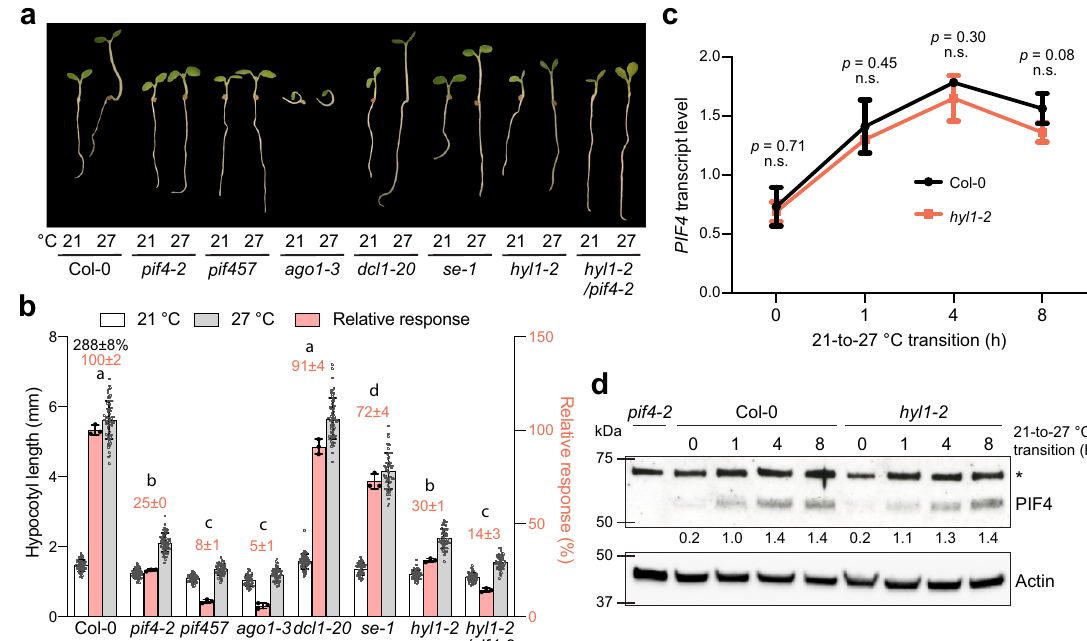
c qRT-PCR analysis of the PIF4 transcript levels in 4-d-old Col-0 and hyl1-2 seed- lingsgrownunder50 μ molm − 2 s − 1 Rlightattheindicatedtimepointsduringthe21- to-27°C transition. Thetranscript levelswere quanti fi ed relative to those of PP2A . Errorbarsrepresentthes.d.ofthreebiologicalreplicates.Thecentersoftheerror bars represent the mean values. Statistical signi fi cance was analyzed using a two- tailed Student ’ s t-test. d Immunoblot analyses of PIF4 protein levels in response to elevated temperature. Four-day-old Col-0 and hyl1-2 seedlings grown at 50 μ mol m − 2 s − 1 R light at 21°C were transferred to 27°C under the same light con- ditions forupto8h, and sampleswere collectedatthe indicatedtime points.The dark-grown pif4-2 sample was used as a negative control. Actin was used as a loading control. The relative levels of PIF4, normalized to actin, are shown underneath the PIF4 immunoblots. The asterisk indicates nonspeci fi c bands. The experiment was repeated three times with similar results. The source data underlying the hypocotyl measurements in ( b ), the qRT-PCR analysis in ( c ), and the immunoblots in ( d ) are provided in the Source Data fi